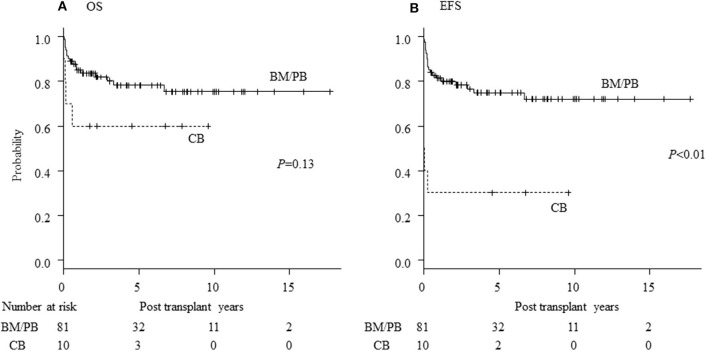
Influence of stem cell source for HCT of CGD. Influence of stem cell source of transplantation on (A) overall survival (OS) and (B) event-free survival (EFS) of CGD patients undergoing HCT. CB, cord blood cell transplantation; BM, bone marrow transplantation; PB, peripheral blood stem cell transplantation.